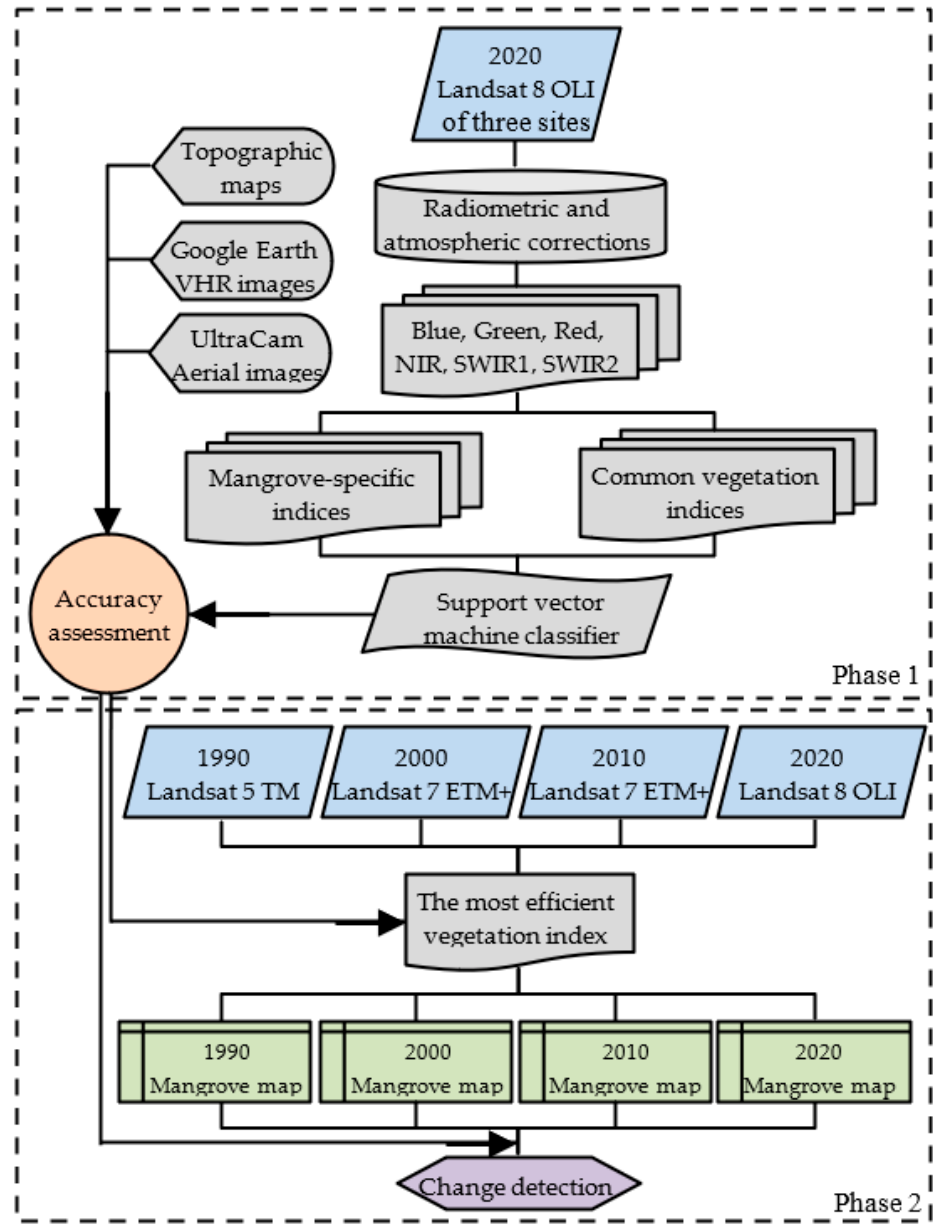
Figure 2. The methodological framework of Iran’s mangrove forest assessment.